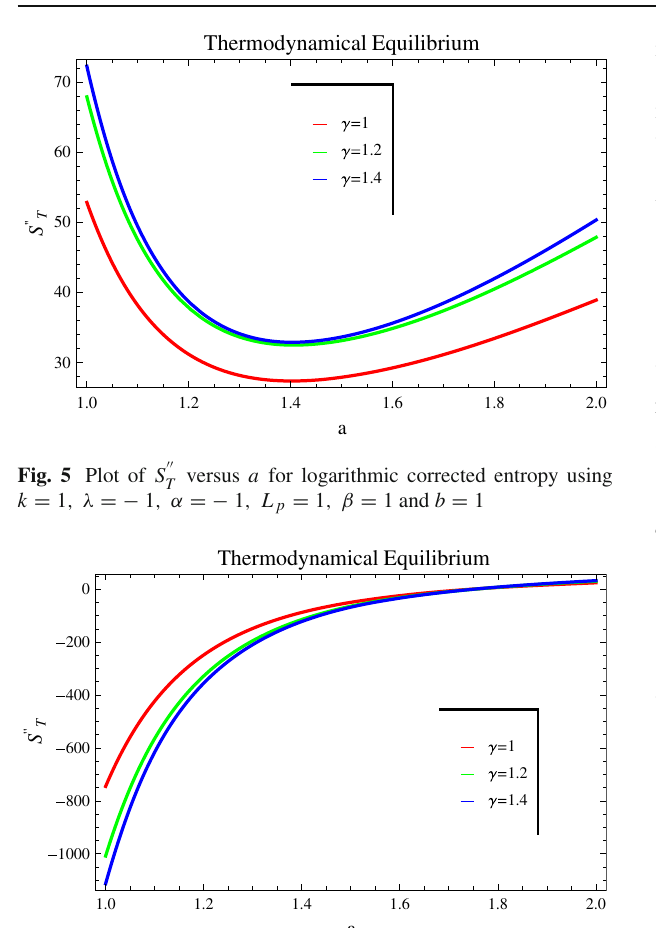
Fig. 6 Plot of S (cid:7)(cid:7) versus a for logarithmic corrected entropy using T k = 1 , λ = − 1 , α = − 1 , L p = 1 , b = 1 and β = − 1 in outer